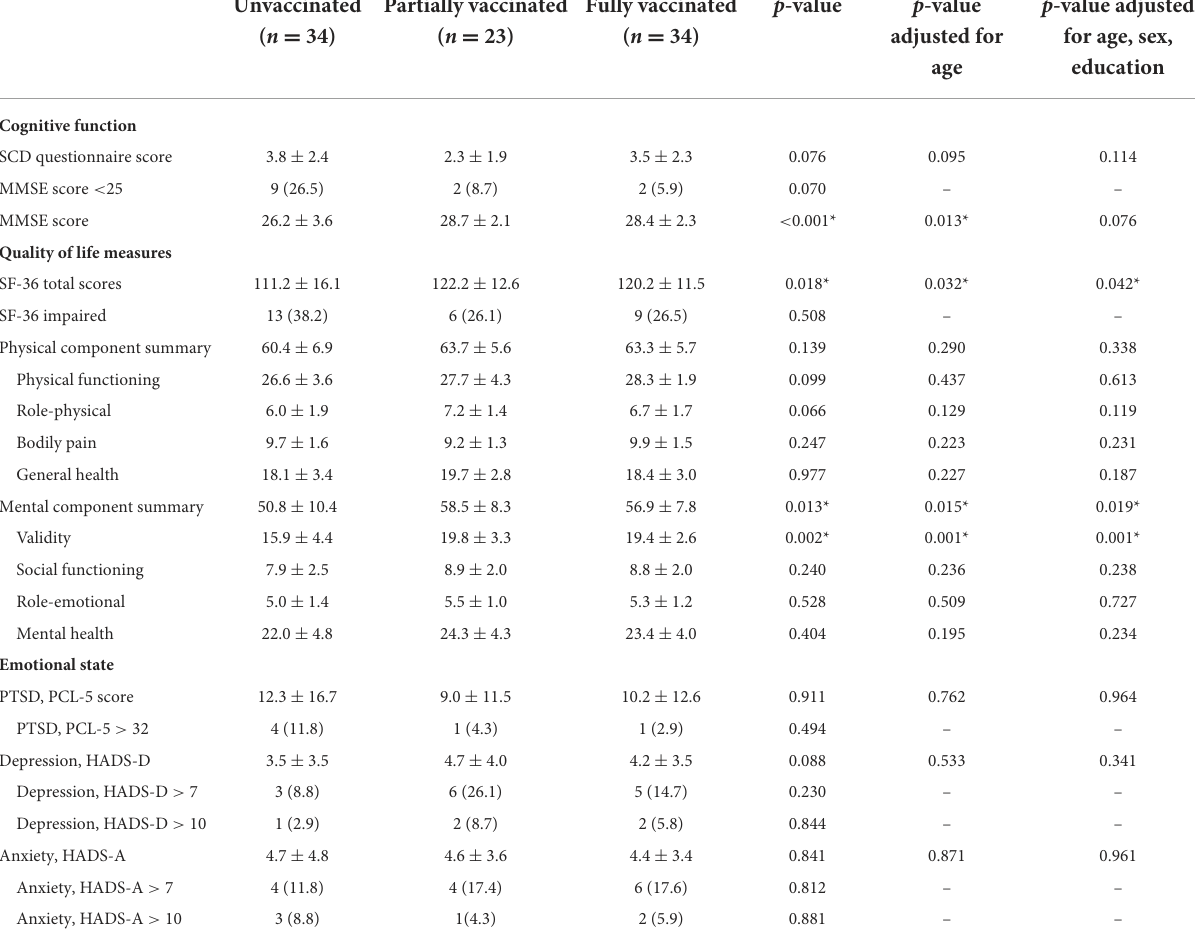
TABLE 3 Cognition, quality of life and emotional state in COVID-19 patients with different vaccination statuses.